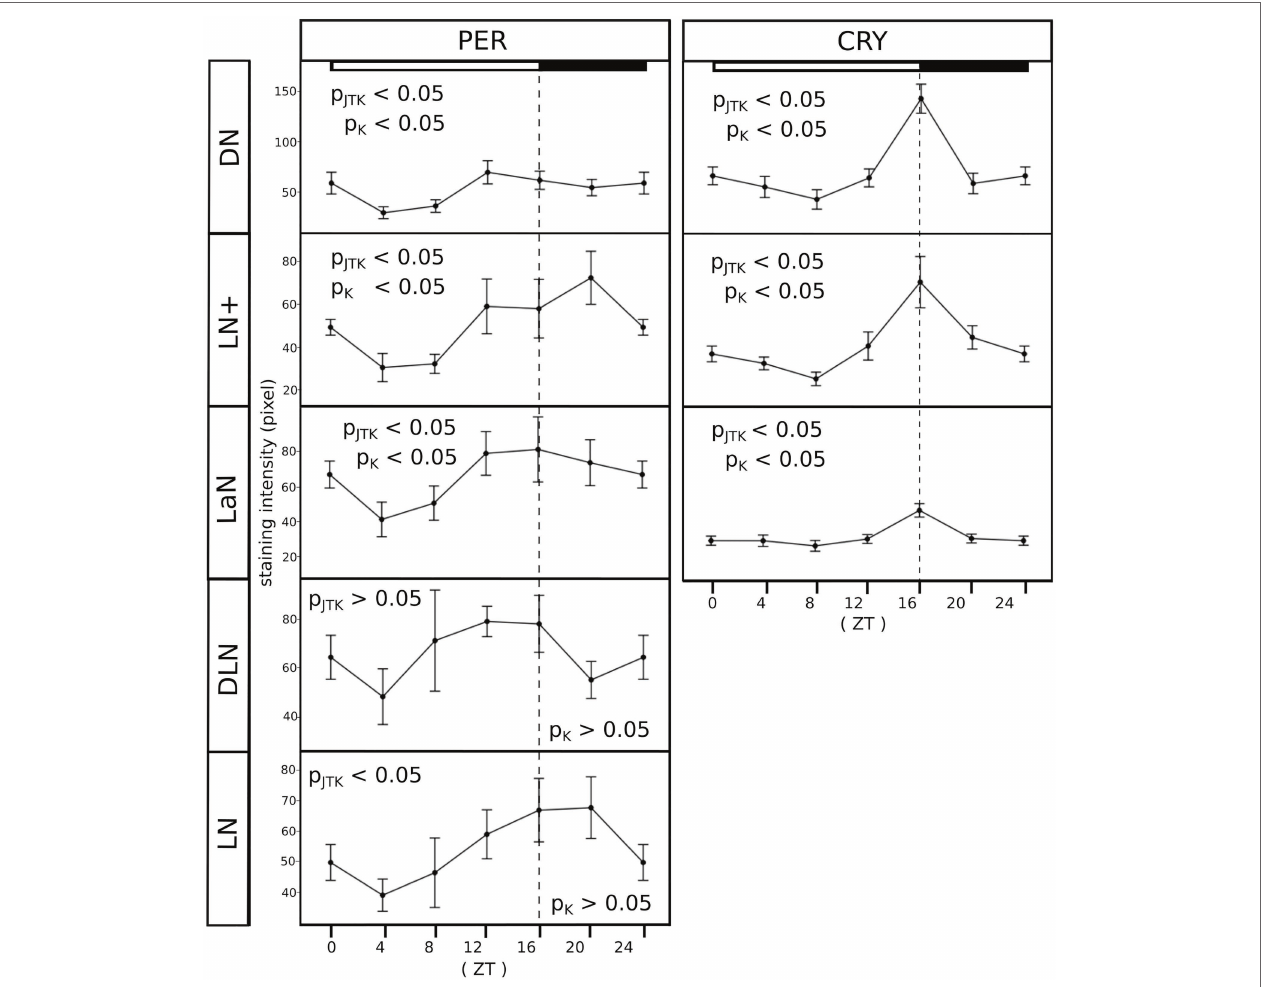
FIGURE 7 | All clusters oscillate in a daily manner. PER and CRY staining was evaluated at six time points (ZT, Zeitgeber time). Each point of the curves represents the average between the intensities calculated in 7–10 brains. For clarity, ZT0 was plotted again at ZT24. The X-axes depict the time points (ZT) at which aphids were collected and the Y-axes depict the staining intensity. Error bar: standard error. P JTK , p -value resulting from the JTK_CYCLE analysis and p k , p -value resulting from the Kruskal–Wallis test. The exact p- values are reported in Table 1 . The white/black bars show the illumination regime at which aphids where entrained (white bar: 16 h of light. Black bar: 8 h of darkness).